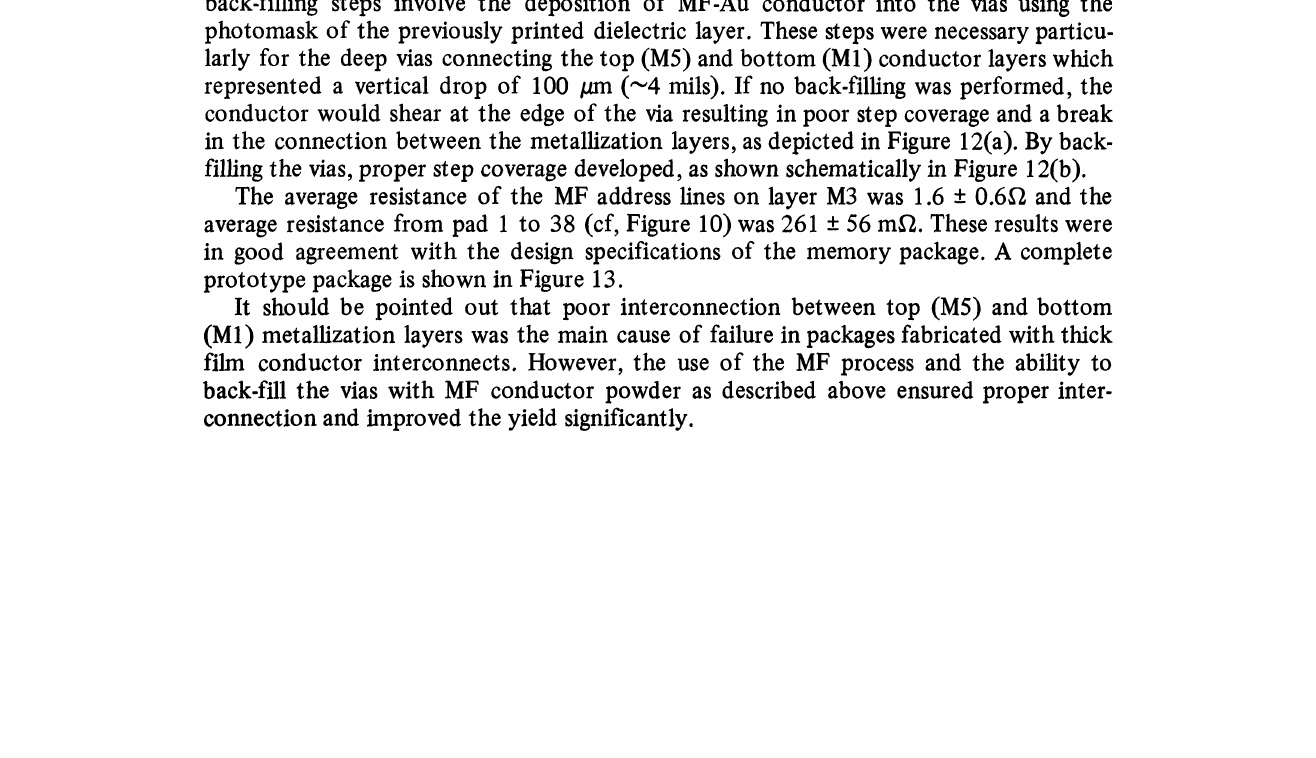
FIGURE 12 Schematic &awing of a 100 tm deep via connecting top and bottom metallization layers (a) without back-filling where shearing of top conductor occurred at the sites indicated by the arrows and (b) with back-filling of the via which eliminates shearing and produces smooth step